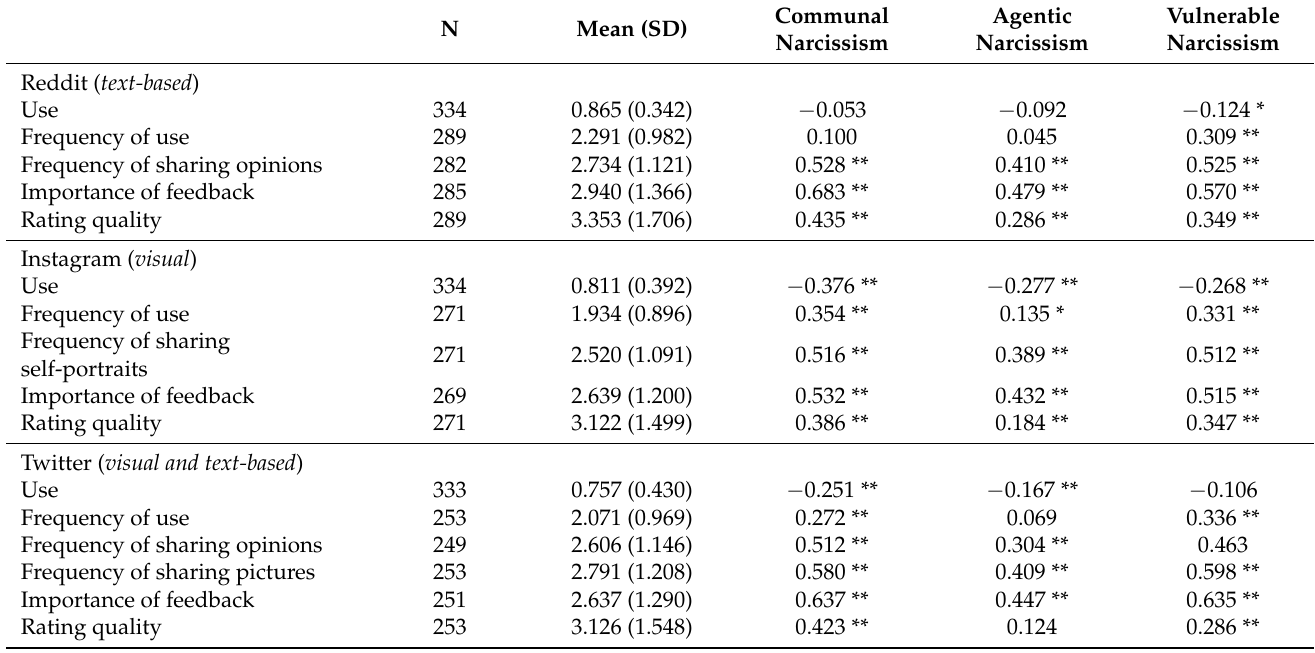
Table 1. Means, standard deviations (SD) and Pearson correlation coefficients for the three types of narcissism (communal, agentic and vulnerable) and social media